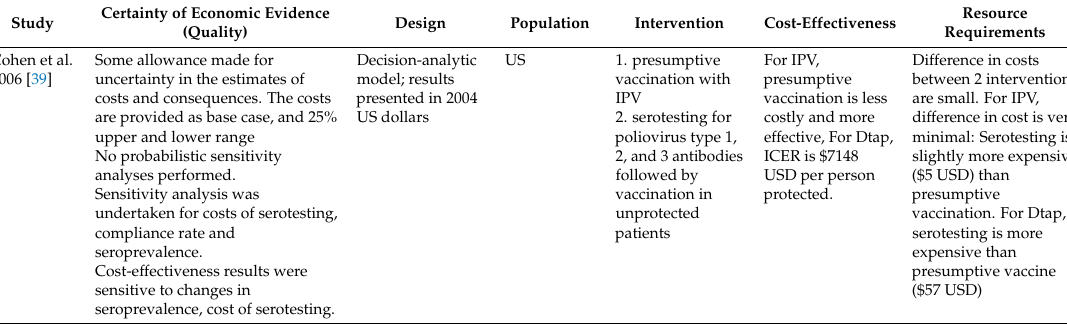
Figure 2. PRISMA 2009 Flow Diagram for Cost-Effectiveness of Vaccination Strategies. Table 2. Characteristics of Studies—Cost-Effectiveness of Vaccination Strategies.